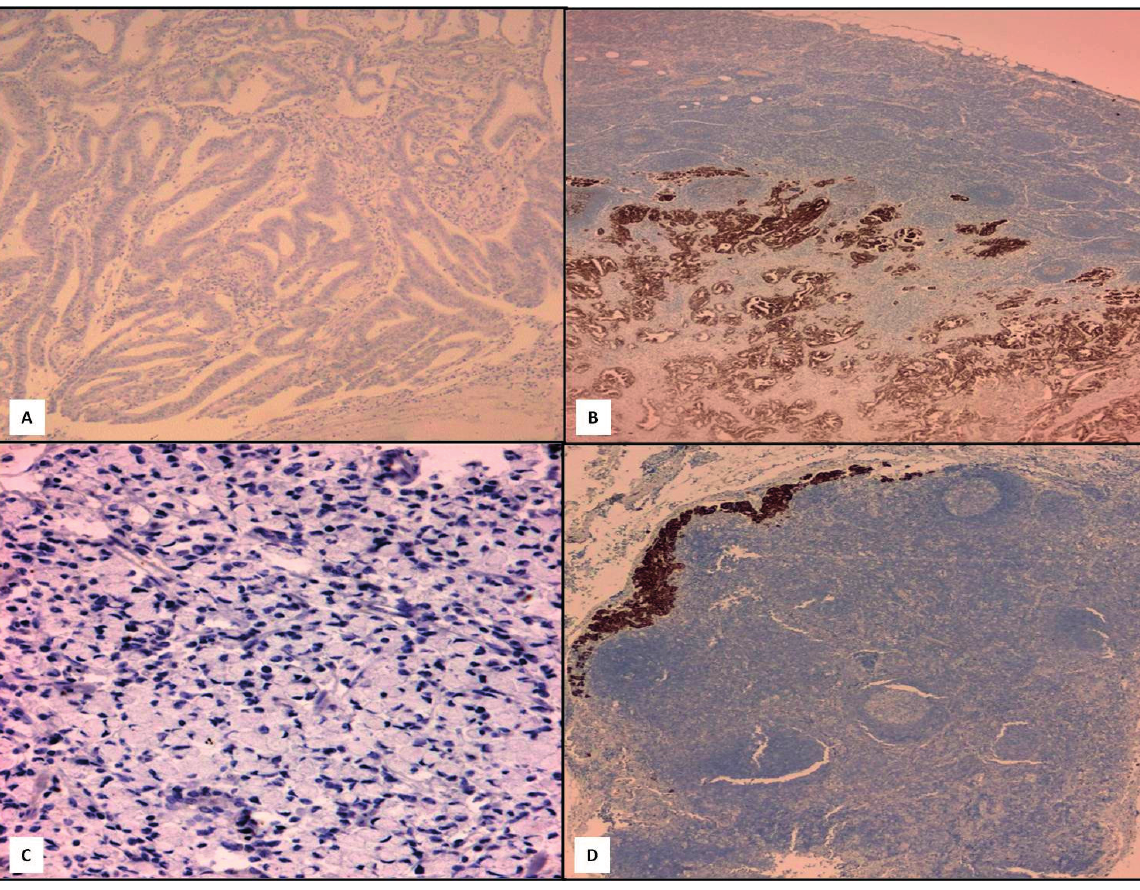
Figure 2. Two cases of positive conversion, one example in the GC intestinal type ( A , 160×; B , 120×) and one in diffuse type ( C , 160×; D , 120×) (IHC, Mayer’s haemalum